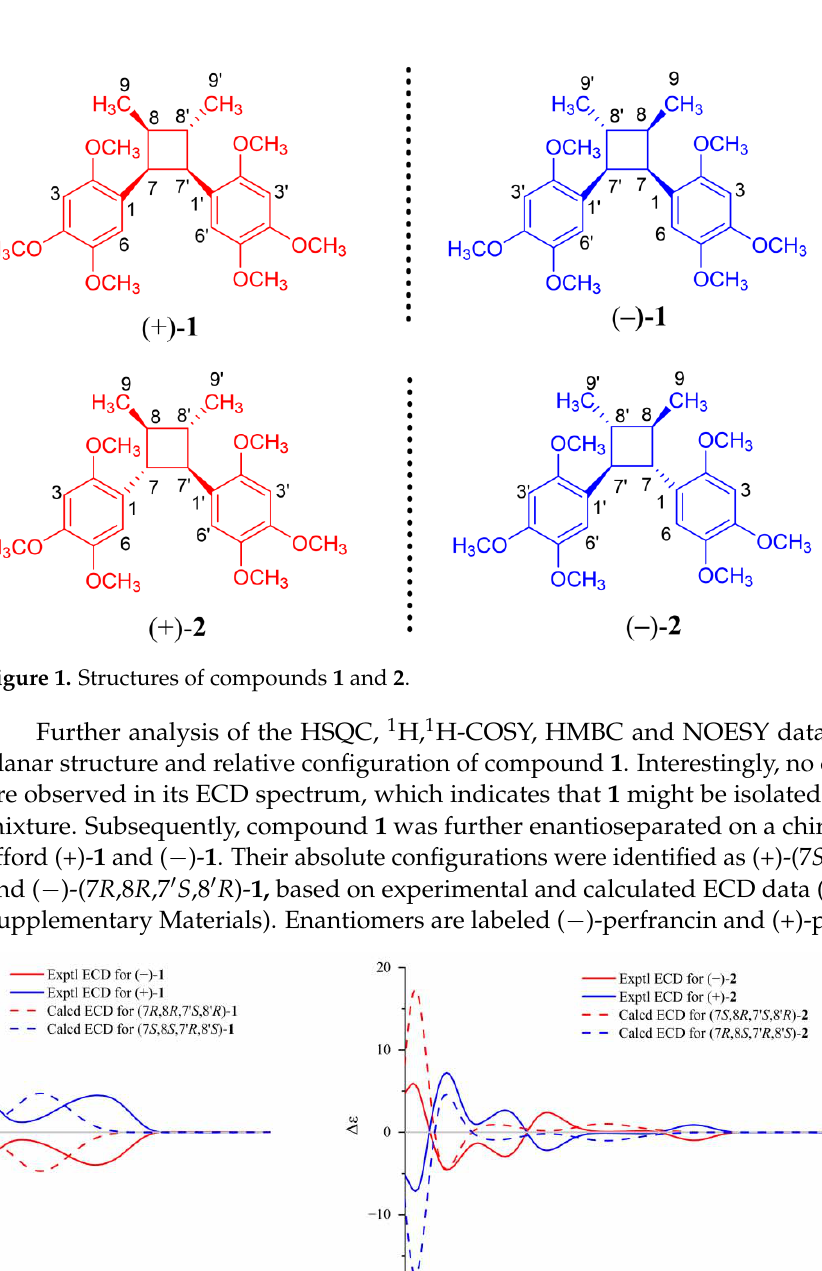
Figure 2. Experimental and calculated ECD spectra of 1 and 2 .